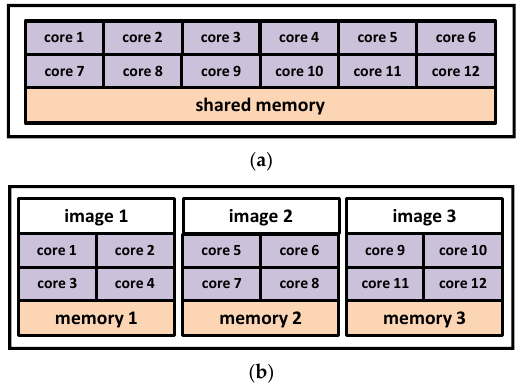
Figure 1. Parallel processing example using OpenMP and CAF: ( a ) Shared memory of OpenMP; ( b ) Distributed memory of CAF.